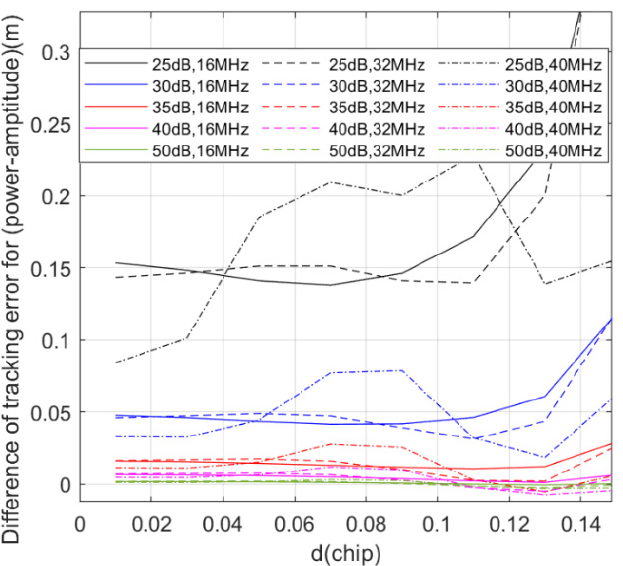
Figure 8. The DLL standard deviation of the ‘power ratio combination’ minus the ‘amplitude ratio combination’ for the B1C (L1C).